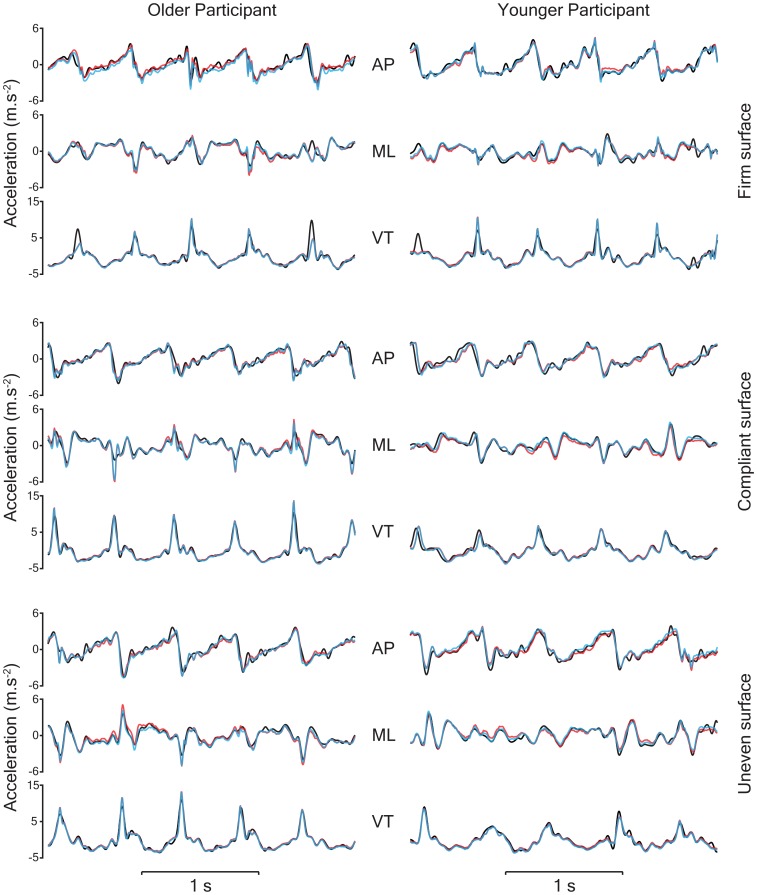
Representative raw three-dimensional trunk accelerations for an older and younger participant collected using the Vicon system (black) and the InertiaCube3 device following gravity compensation using the detrending (red) and quaternion (blue) methods.